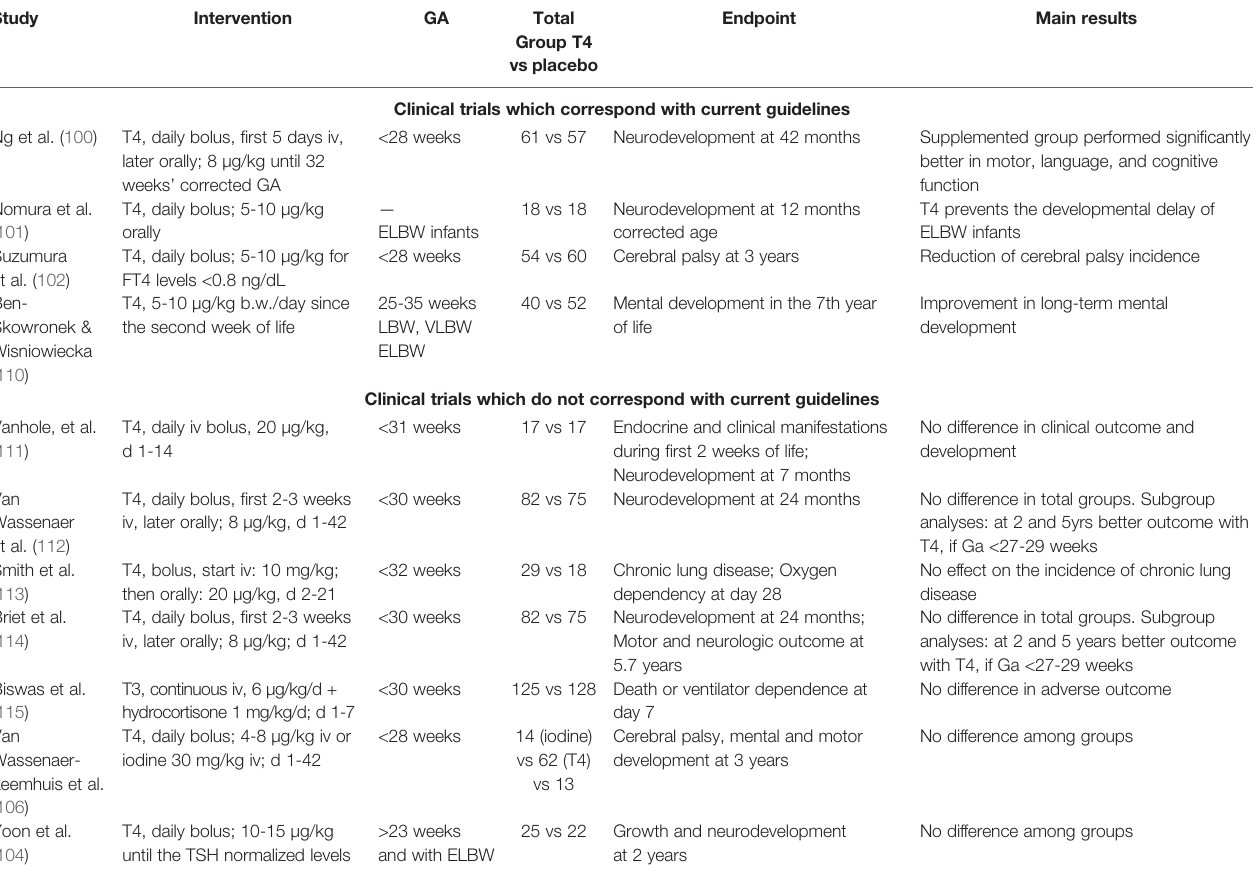
TABLE 1 | Summary of studies concerning the T4 treatment and its neurodevelopmental